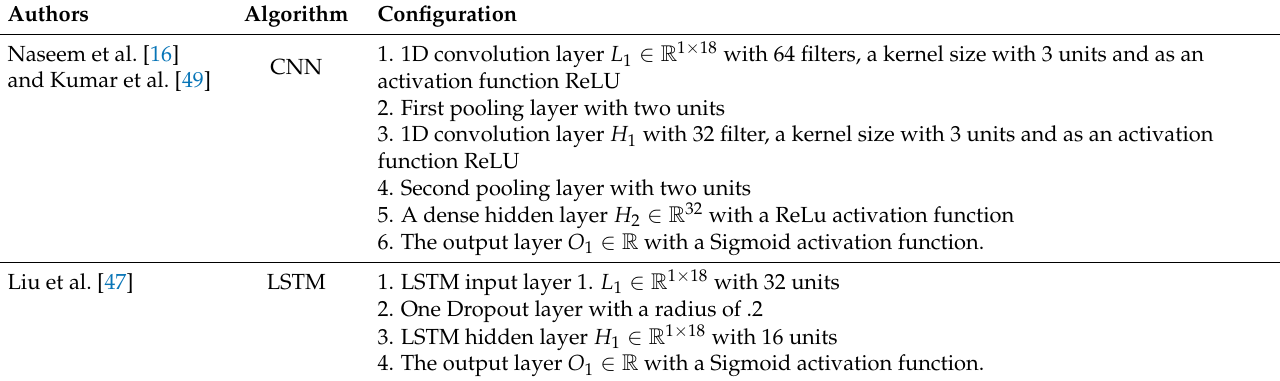
Table 9. List of authors who presented cryptojacking solution proposals, using DL algorithms. The layers and units used for the construction of the models are